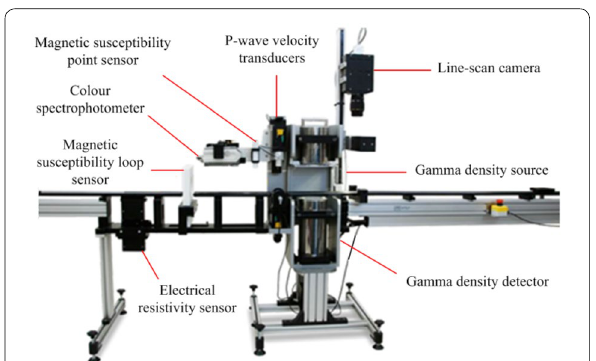
Figure 15 Multi-sensor core logger